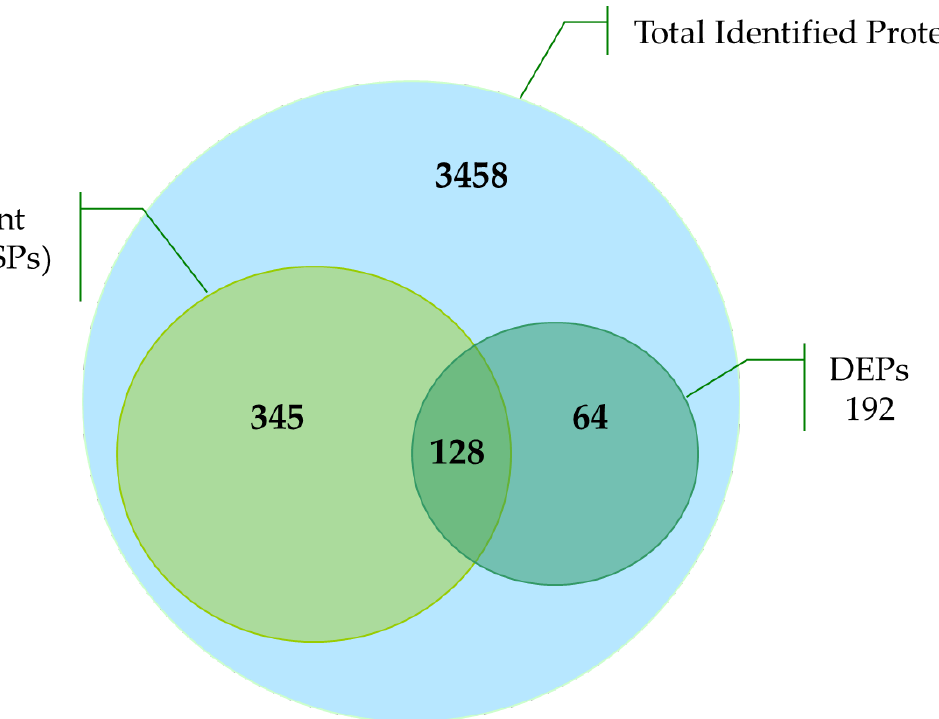
Figure 3. LDA-SPs and DEPs Diagram. The figure shows the portion of LDA Significant Proteins (LDA-SPs) and differen- tially expressed proteins (DEPs) compared to the total identified distinct proteins in all processed samples and replicates.